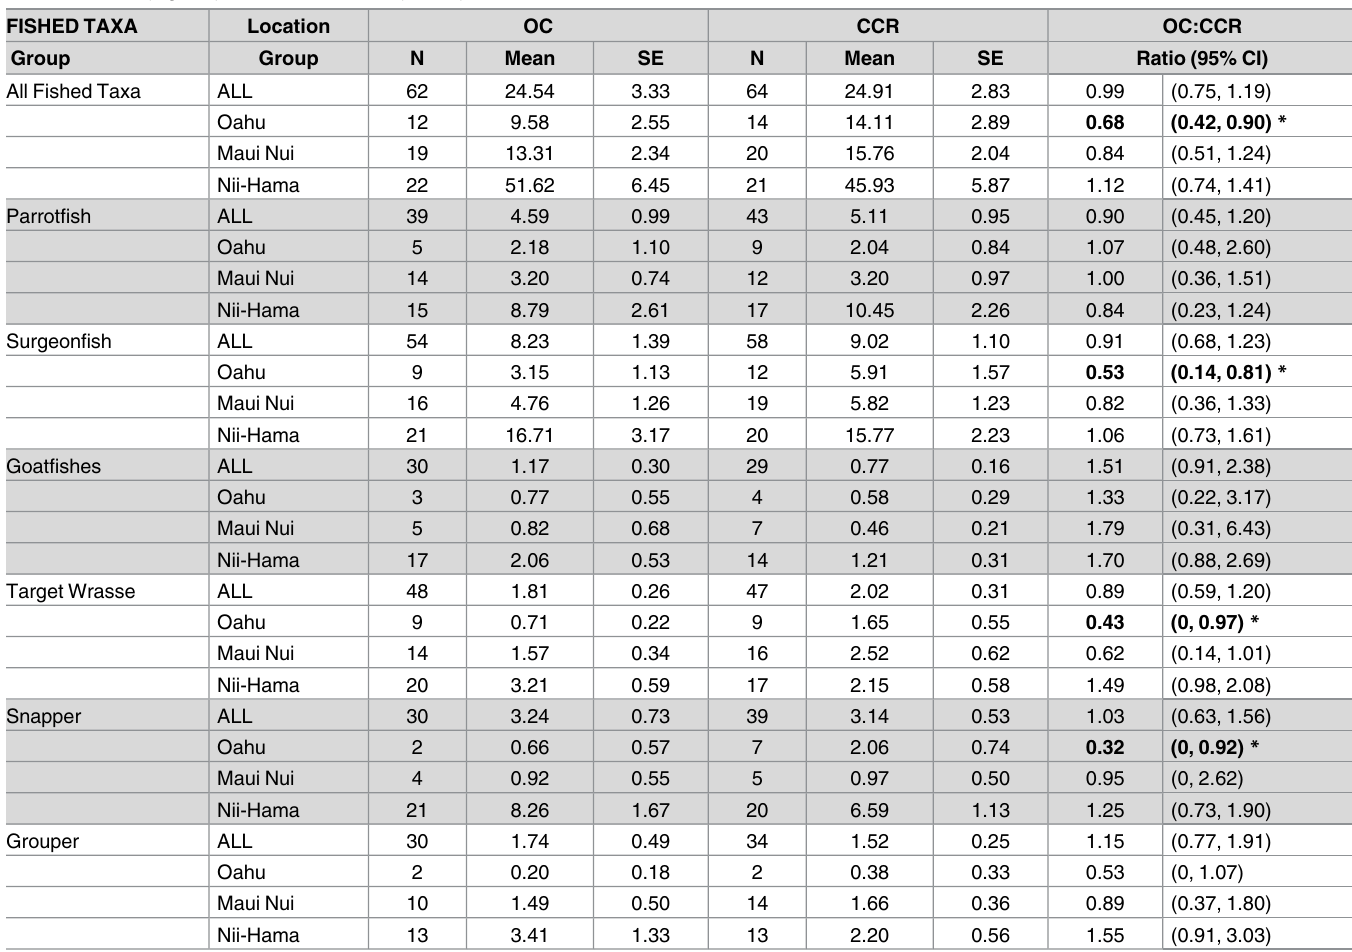
Table 2. Summarytable for biomass (g/m 2 ) of fished taxa. Fished taxa (cid:21) 20 cm TL (except A . triostegus and C . strigosus (cid:21) 15 cm). N = number of sites with the group observed, OC:CCR Ratio = ratio of mean OC value to mean CCR value with 95% confidenceinterval (low 95% CI, high 95% CI). Significant dif- ferencesbetweenCCR and OC (i.e. 95% CI of OC:CCR not overlapping1) are markedwith an asterisk ( * ) and shownin bold. Number of sites at each location was Oahu: n = 15, Maui Nui: n = 20, Niihau-Hamakua: n = 22 and all sites: n = 66. Locationgroups are listed in order of presumeddeclining spearfishingpres- sure from Oahu (highest) to Niihau-Hamakua